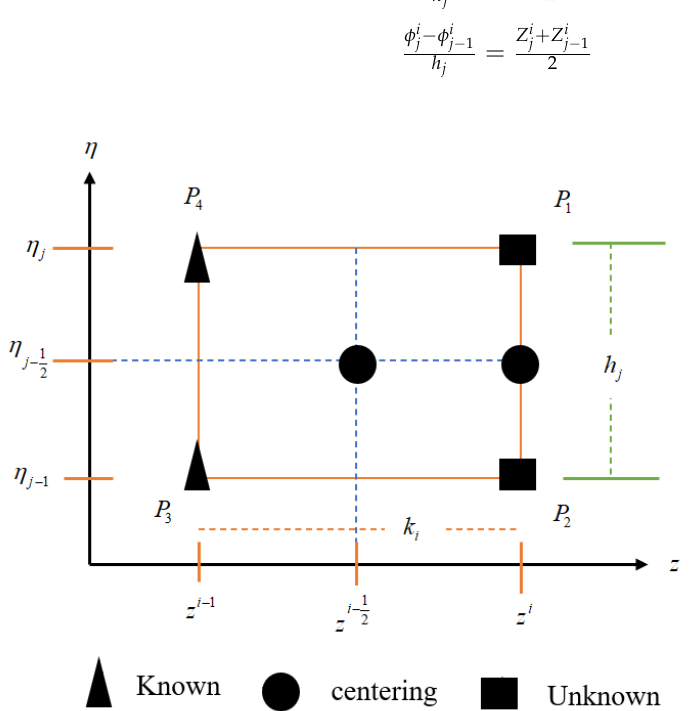
Figure 2. Schematic diagram for domain discretization.